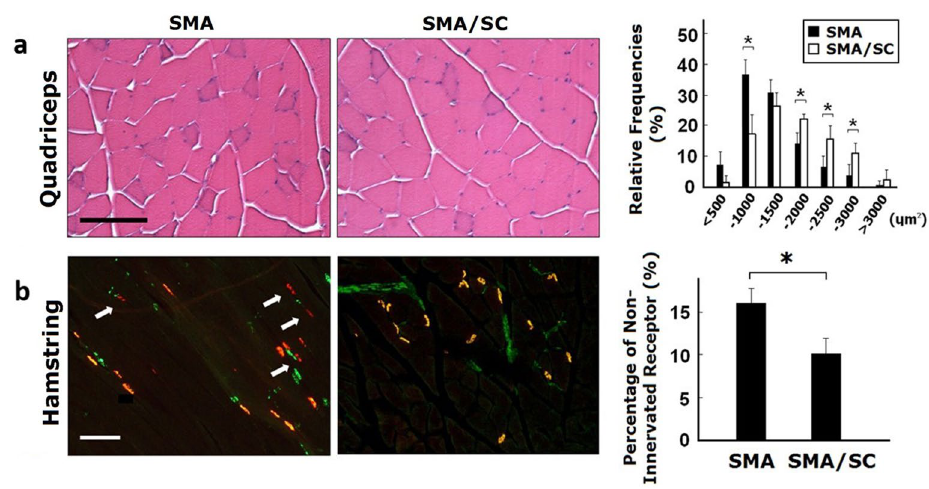
Figure 9. Comparison of muscle in SMA mice with or without hAFSC transplantation. n = 16. (a) H&E staining of tissue from quadriceps. Blue color indicated myocytes. (b) Immunocytochemistry staining of tissue from hamstring. Red color indicated non-innervated receptors. Higher relative frequency of myocyte and lower percentage of non-innervated receptors were detected in SMA mice with hAFSC transplantation. hAFSC human amniotic fluid stem cell, SMA spinal muscular atrophy, SC stem